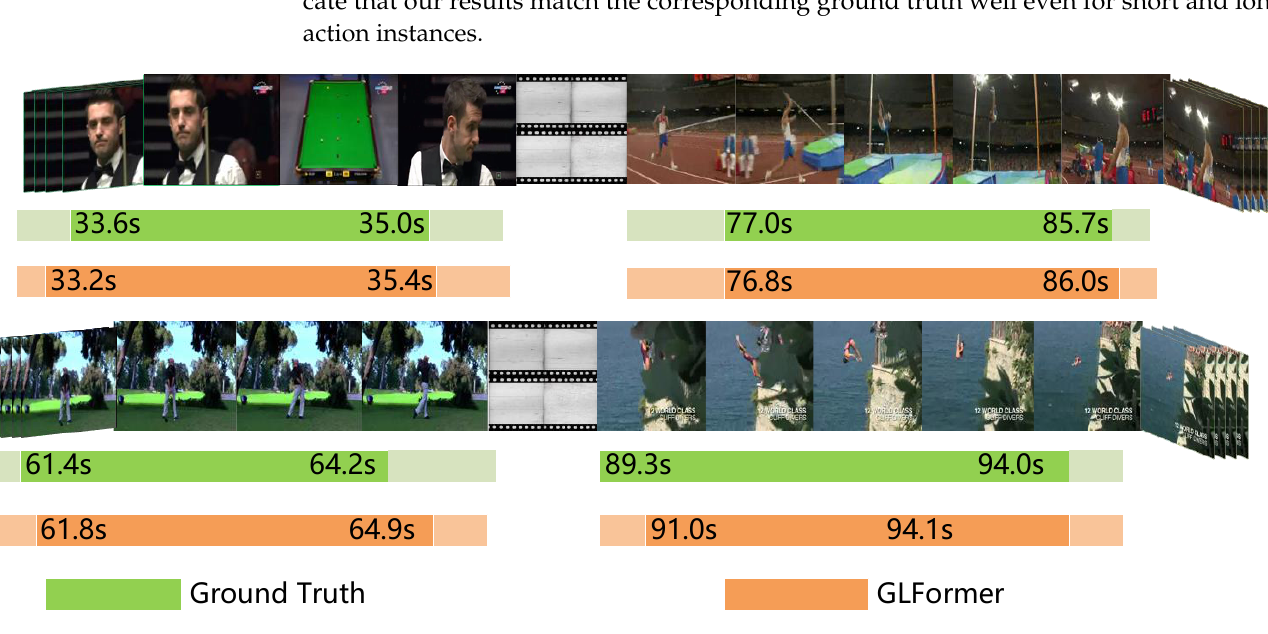
Figure 3. Visualization of four proposals generated by GLFormer on the THUMOS14 dataset, which include short, medium, and long action